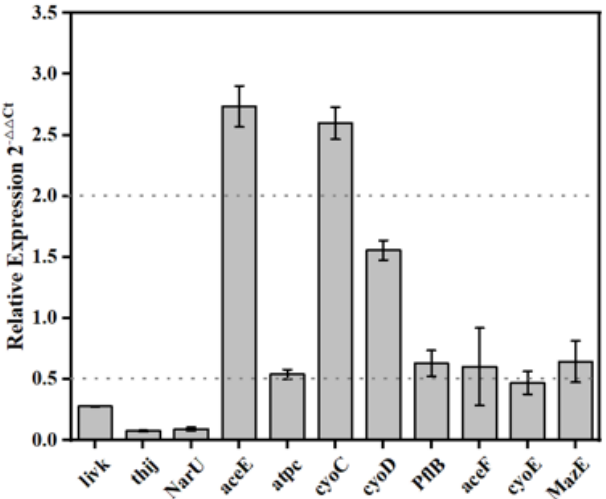
Figure 6. Gene expression of E. coli treated with the PDA-rGO/BiVO 4 composite.